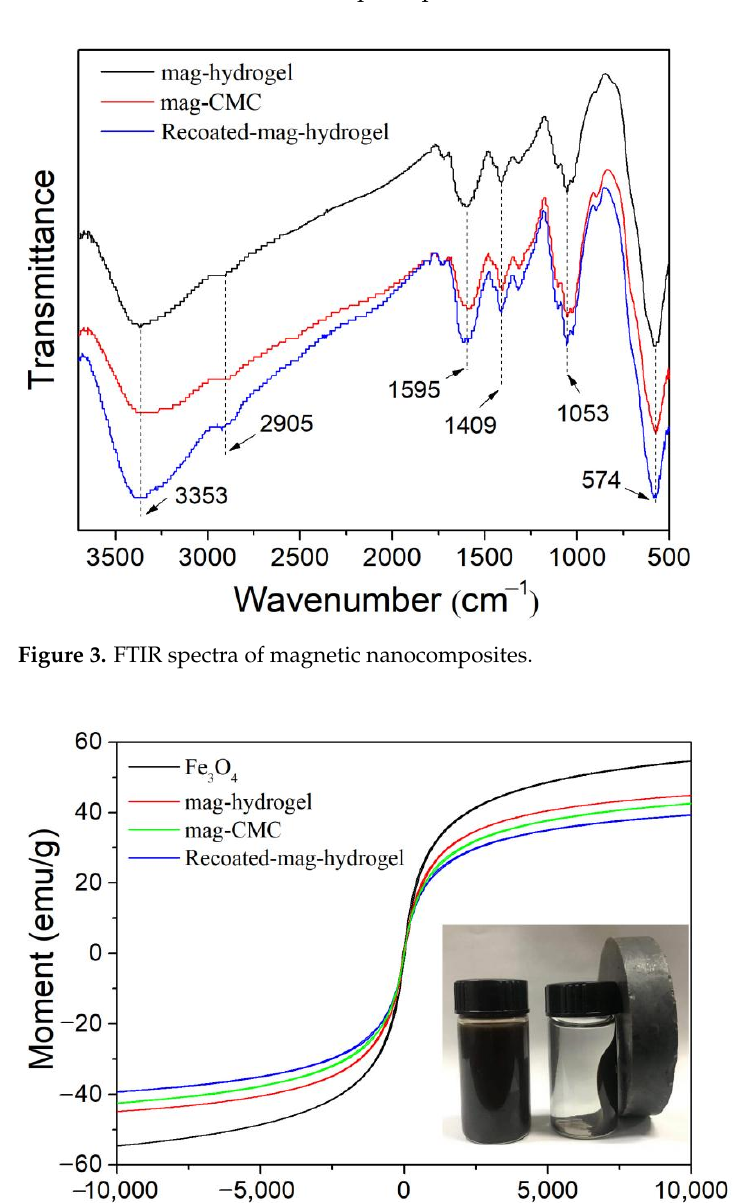
Figure 5. N 2 adsorption-desorption isotherm and pore size distribution curves of magnetic nano- composites. TGA can be employed to quantitatively assay the amount of substrate-attached ma- terial that remained on the surface, the TG results are shown in Figure 6. Gradual degra- dation within 20–180 °C resulted from the removal of free and combined water. The weight loss from 200 to 350 °C corresponded to the decarboxylic process of CMC, AA, or AM molecules. At higher than 350 °C, the weight loss was related to the breaking of C–O bonds in the CMC or CMC-g-p(AA-co-AM) structure. When all the samples were heated